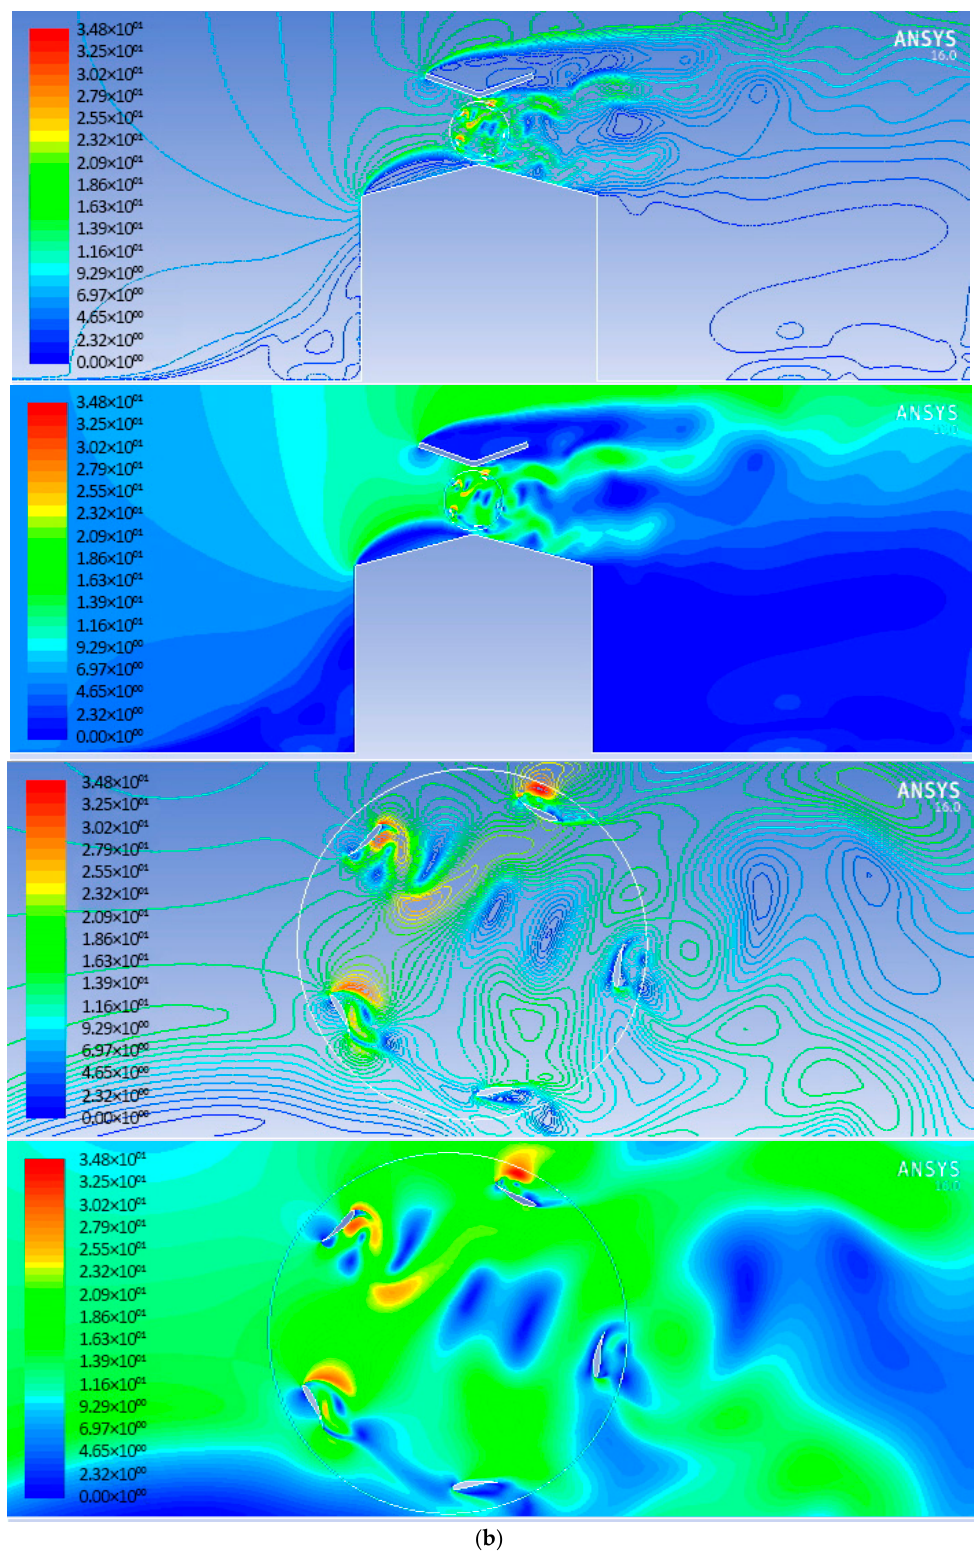
Figure 15. ( a ) Boundary condition and the domain size of the VAWT with the VRGV used in this numerical simulation; ( b ) Velocity contour for the VAWT embedded in the double slope roof and VRGV.